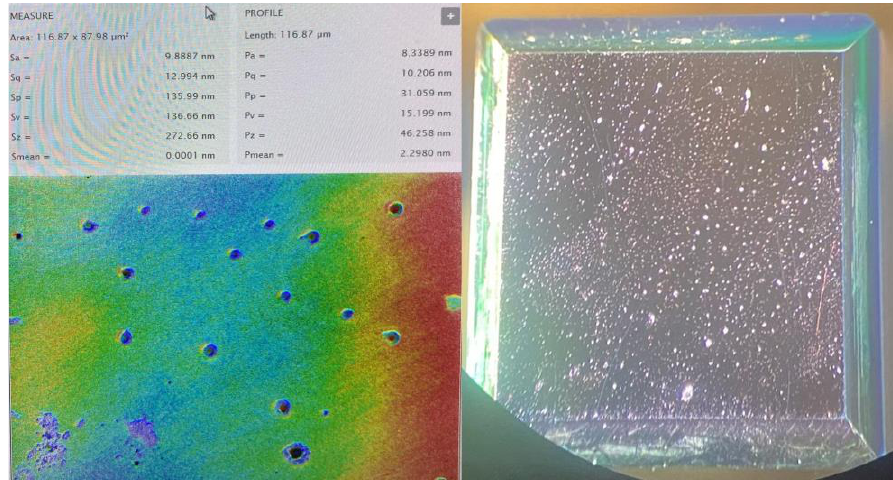
Figure 4. An electronic breakdown of crystal surface. Left — image from profilometer, right — image from optical microscope.